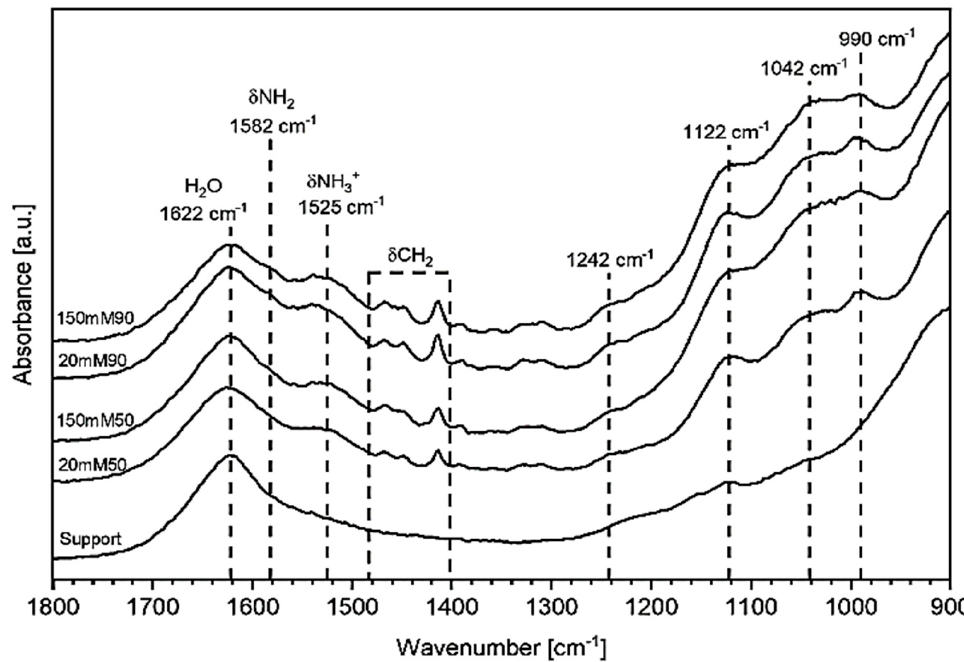
Figure 3. Infrared spectra of 3APPA grafted with mesoporous TiO 2 samples, at the lowest (20 mM) and highest concentrations (150 mM) for two different temperatures: 90 °C and 50 °C. Reprinted from [92] with permission from Elsevier.